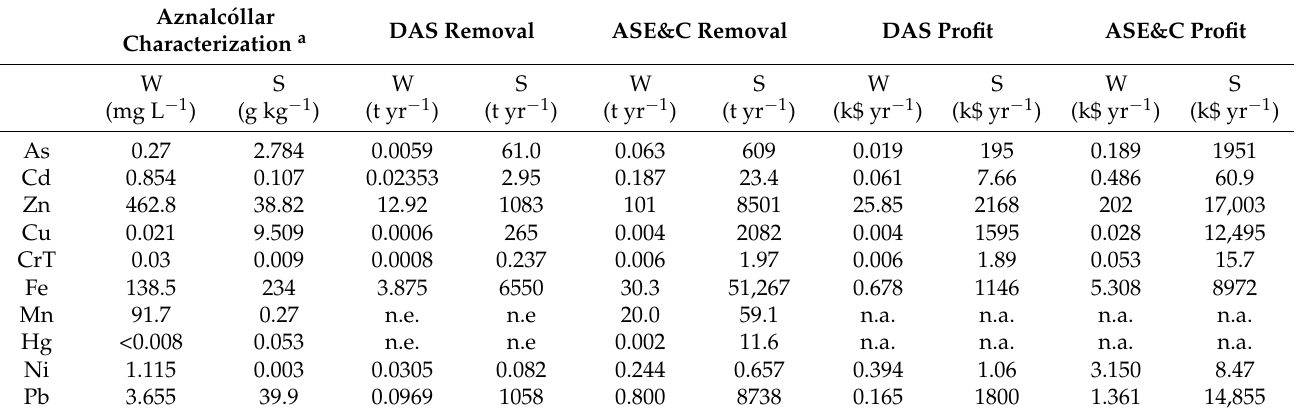
Table 3. Average chemical characterization of water (W) and sludge (S) in the Aznalc ó llar mining spill, and estimation of the costs produced using DAS and ASE&C applied to the water and sludge residues from the “Los Frailes”